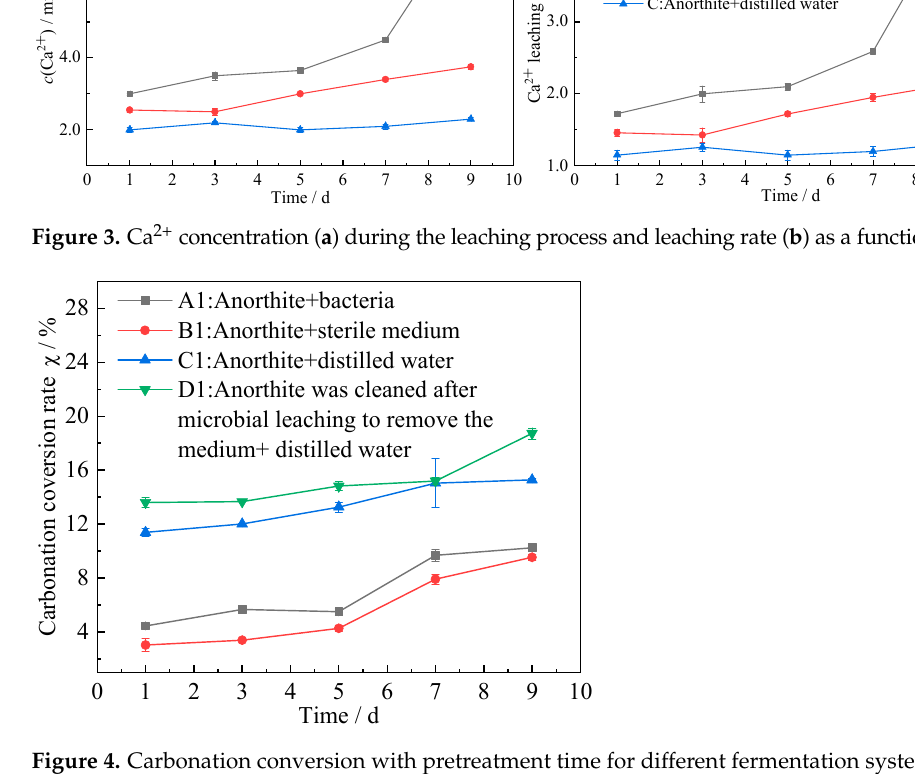
Figure 4. Carbonation conversion with pretreatment time for different fermentation systems.